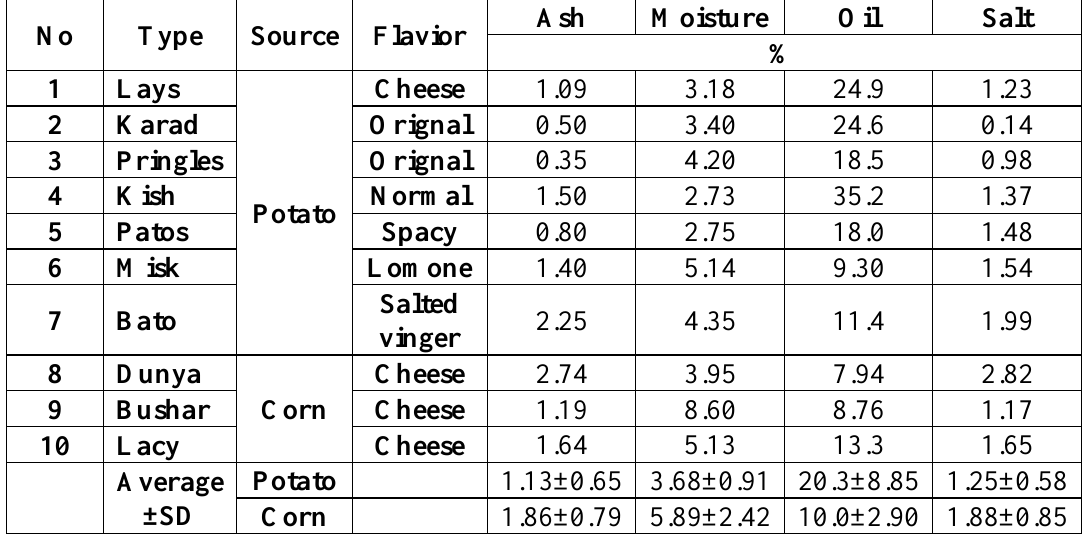
Table1. Physio-chemical properties of the studied potato and corn chips